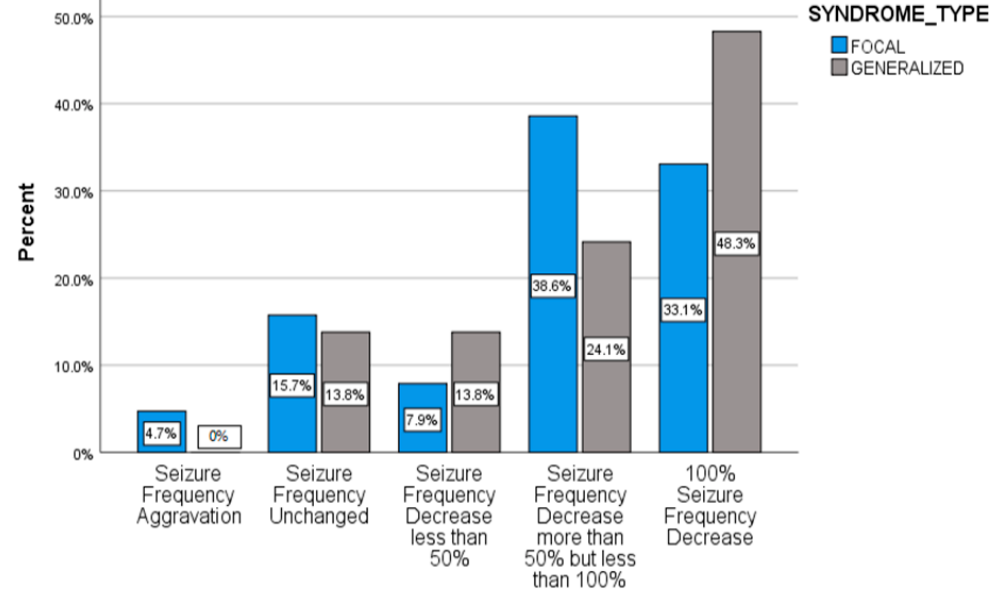
Figure 2. Response rates after BRV initiation correlated to epilepsy